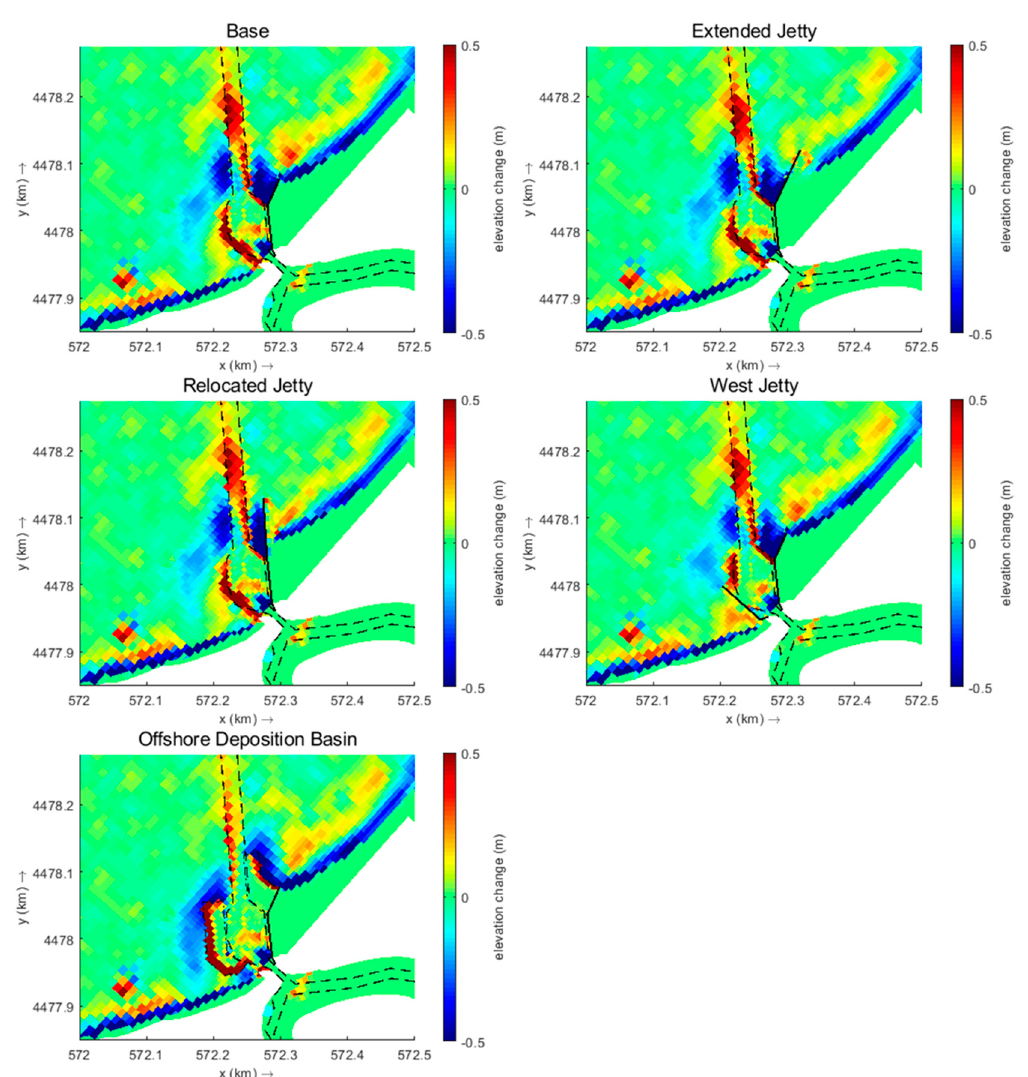
Figure 10. Cumulative sedimentation/erosion for modeled period (28 days): WNW Storm. Area of interest/channel limits by dashed line, jetty by solid black line, and deposition basins by the dot and dashed line.